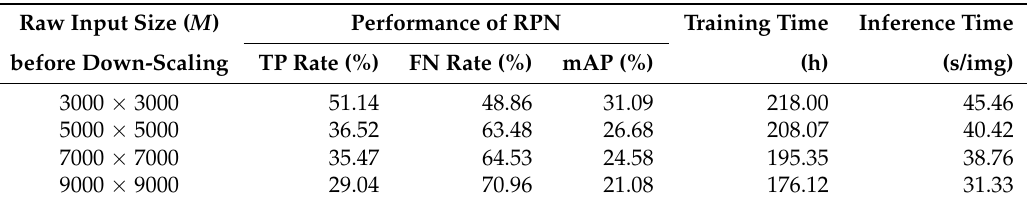
Table 4. Effect of the raw input size before down-scaling in terms of the performance of RPN and computational times for total training and inference process of DHCR.